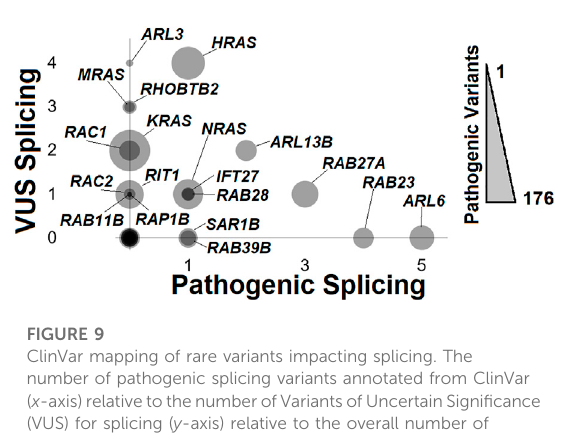
FIGURE 9 ClinVar mapping of rare variants impacting splicing. The number of pathogenic splicing variants annotated from ClinVar ( x -axis)relativetothenumberofVariantsofUncertainSigni fi cance (VUS) for splicing ( y -axis) relative to the overall number of pathogenic variants, including splicing, missense, frameshift, and nonsense(sizeofbubble)foreachofthesmallGTPasegenes.Each bubble with non-zero x- or y -axis values is